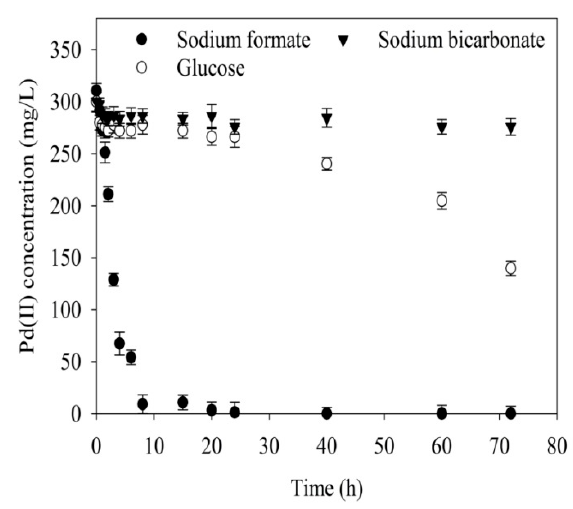
Figure 6. Pd(II) removal by Citrobacter sp. under different carbon sources (sodium formate, sodium bicarbonate, glucose).